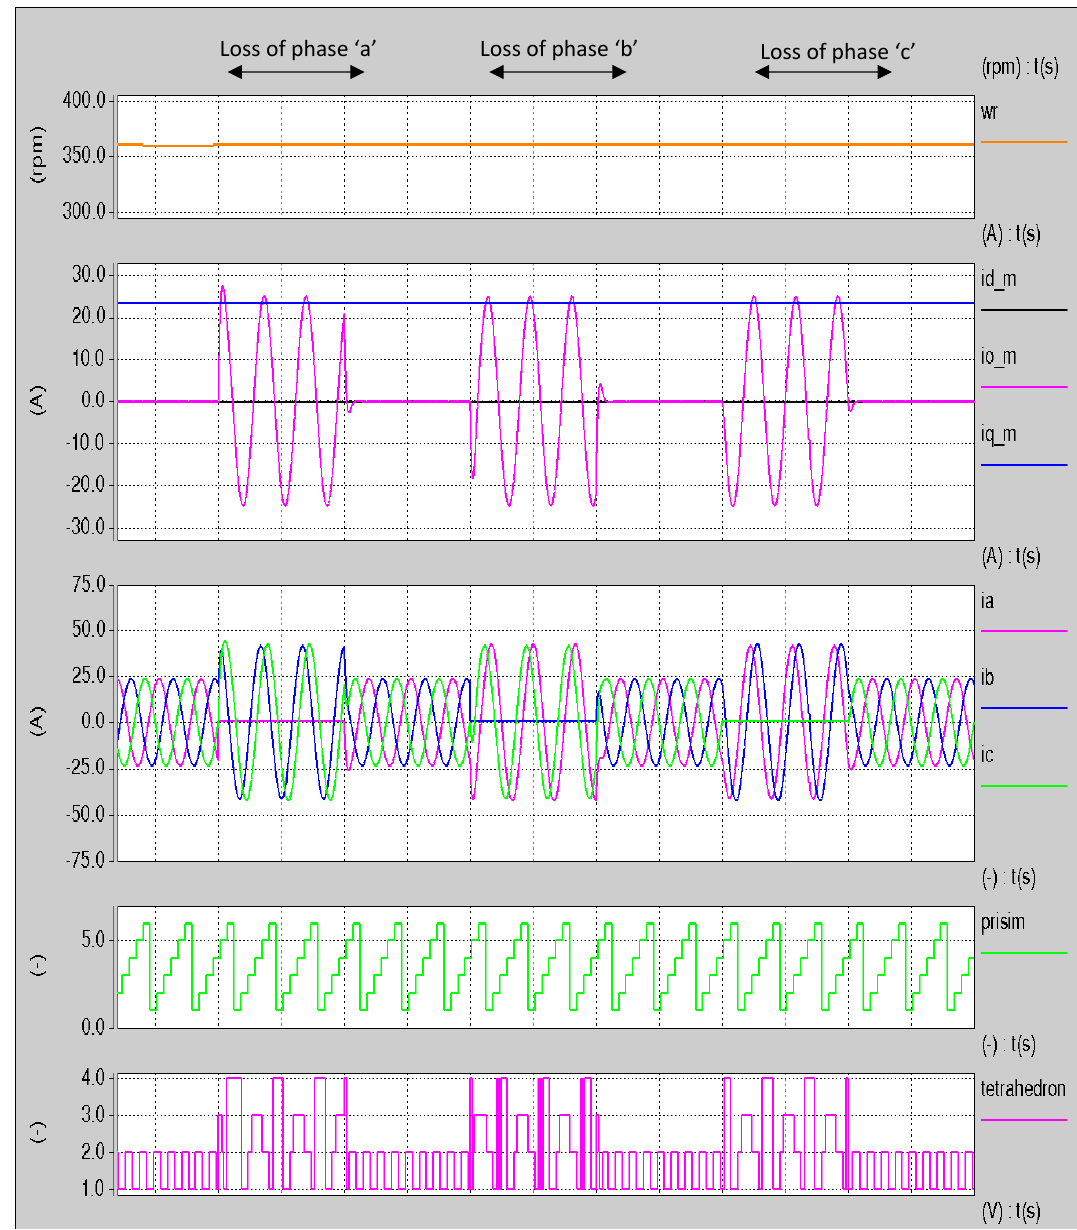
Figure 7. Performance of the fault-tolerant PMSM drive system.